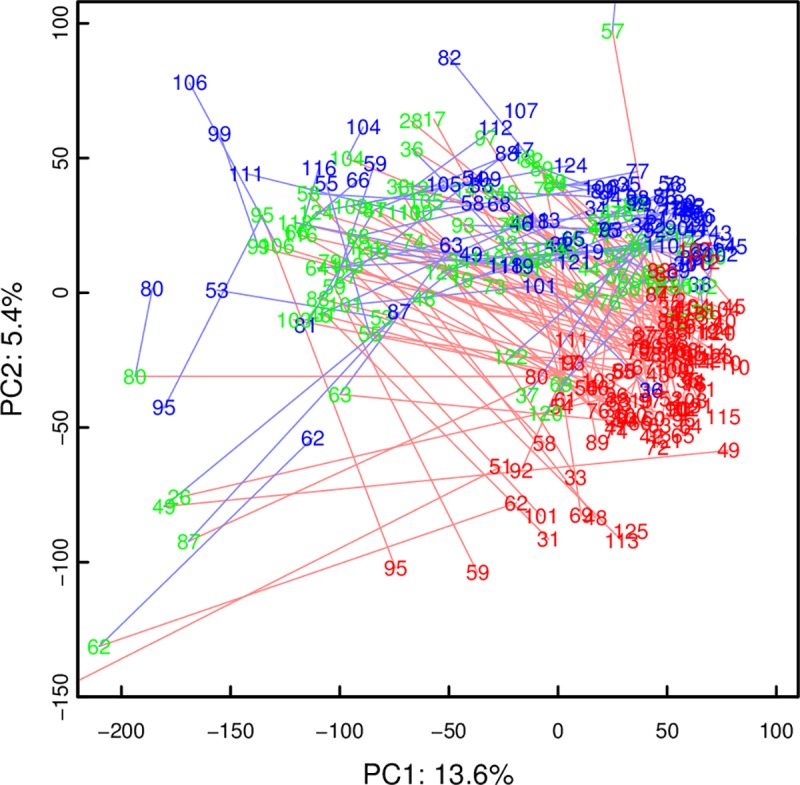
PCA scores plot of plasma spectra.Time points t1, t2, and t3 are red, green, and blue, respectively. Red lines connect time points t1 and t2 of the same animal, blue lines time points t2 and t3. Note how spectra from time point t1, and to a lesser degree time point t3, are clustered while those from time point t2 show more variation.